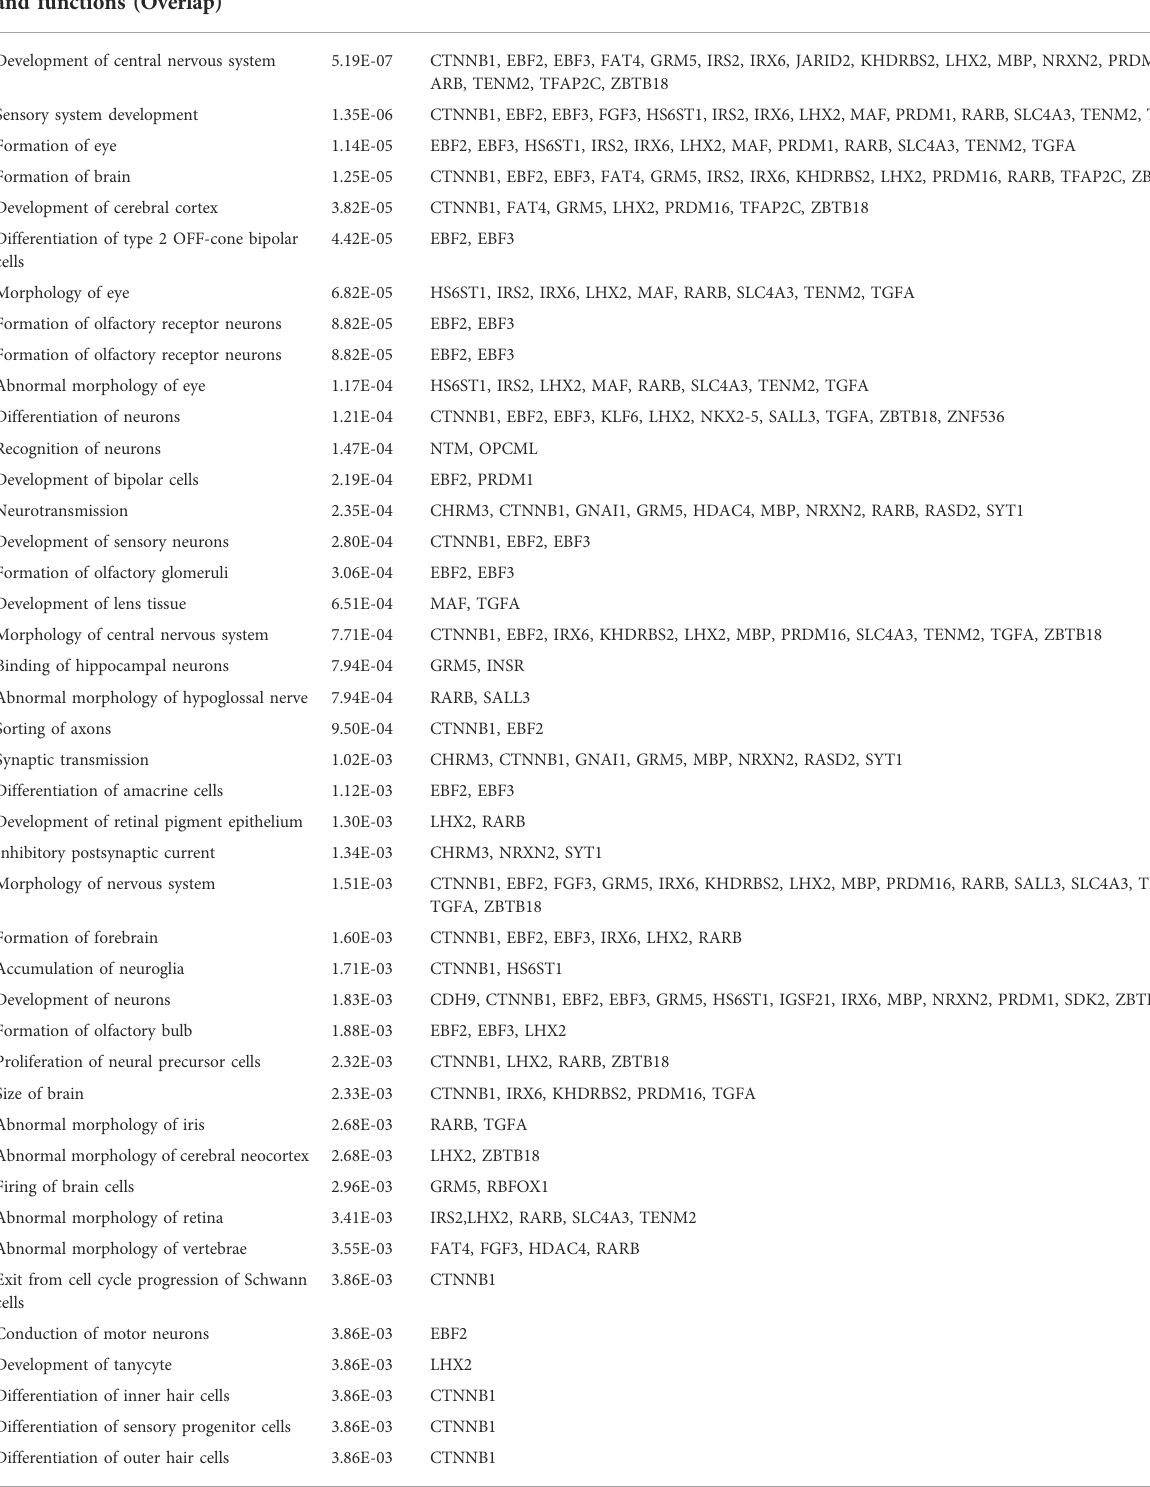
TABLE 4 Nervous system functions enriched among the overlapping DDE DMR-associated genes between the discovery and validation data sets. Nervous system development and functions